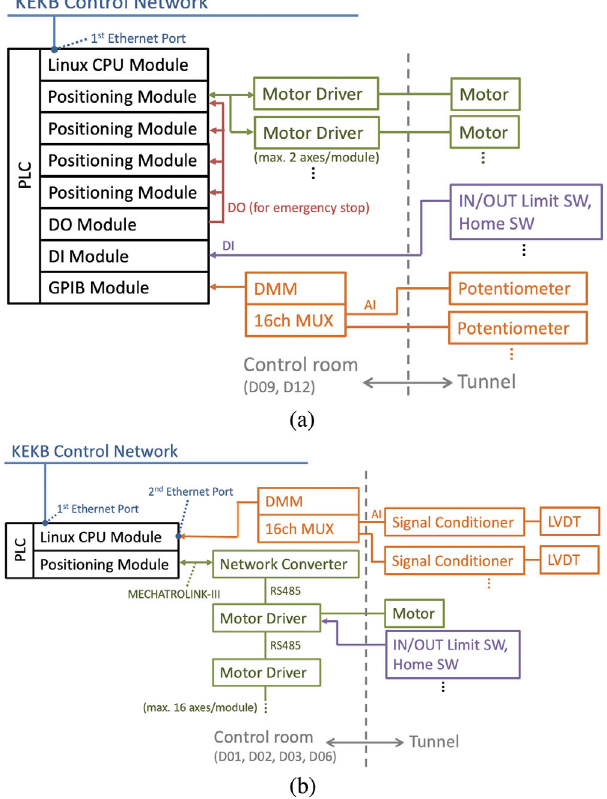
FIG. 11. Schematic configuration of control system for